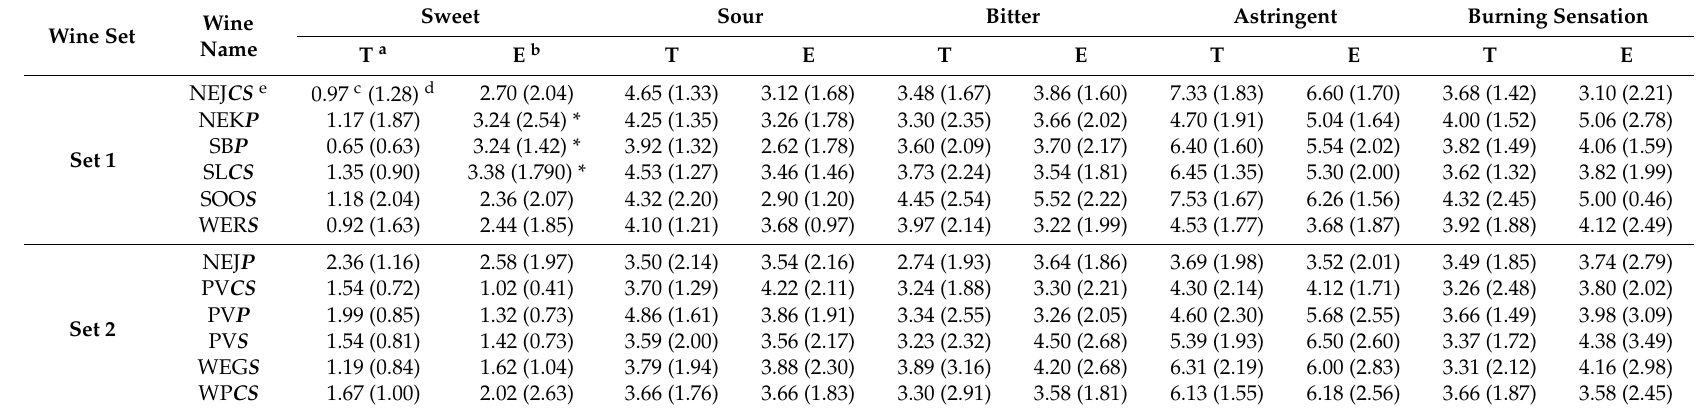
Table 4. Means, standard deviation, and results of ANOVA for the two panels in the “mixed” tasting